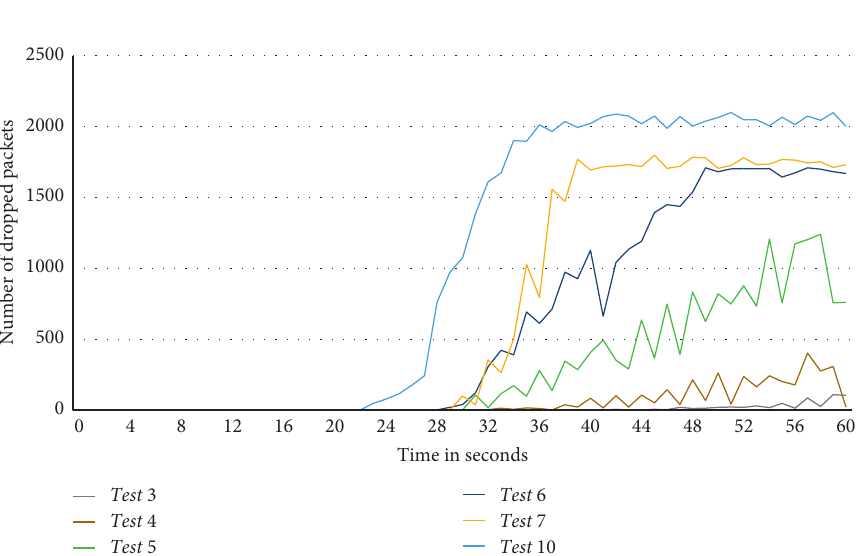
Figure 9: Average percentage of dropped packets.